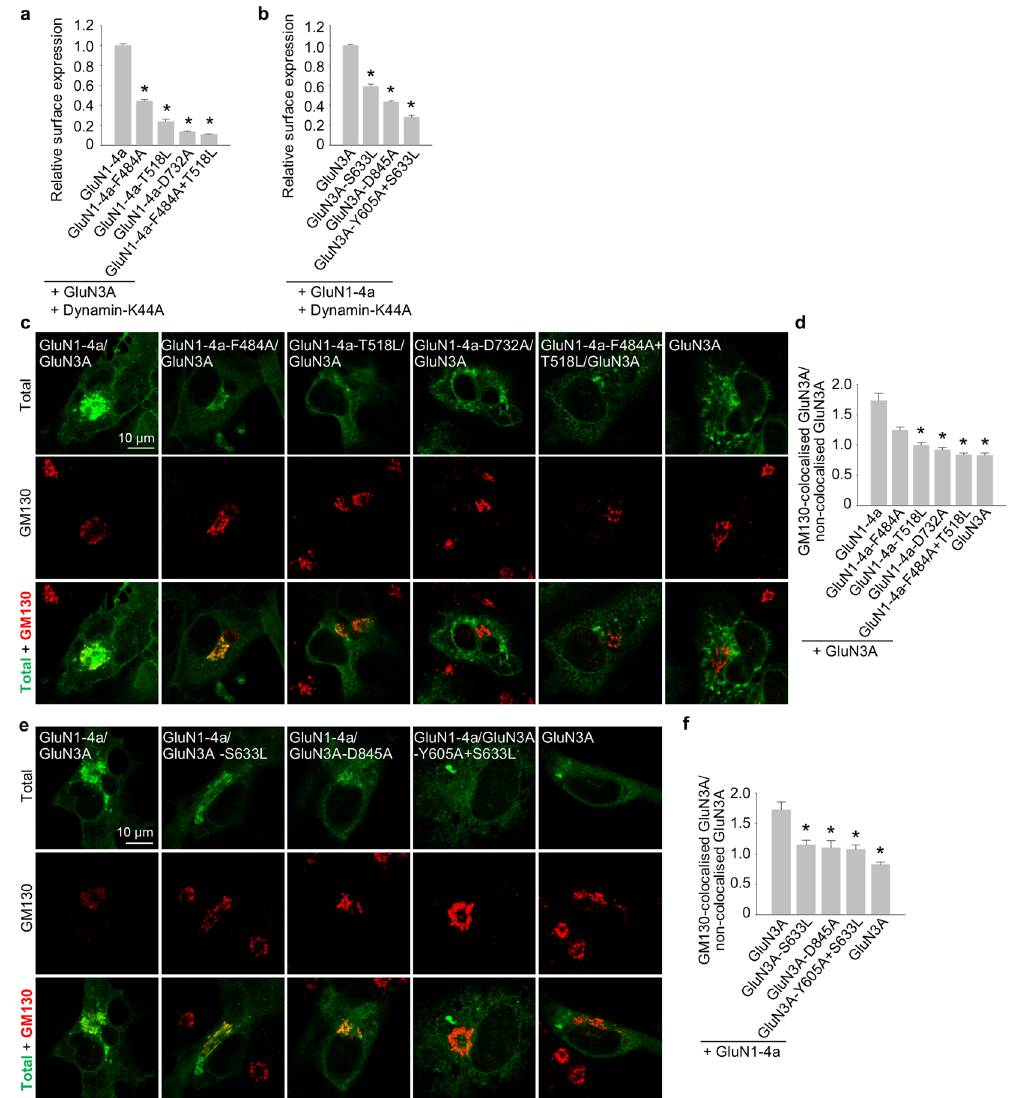
Figure 4. The glycine-binding sites in the GluN1 and GluN3A subunits regulate forward trafficking of GluN1/ GluN3A receptors ( a,b ) HEK293 cells co-expressing the indicated GluN1-4a and GFP-GluN3A (GluN3A) subunits together with the dynamin-K44A were labelled with primary anti-GFP and secondary antibodies in non-permeabilizing and permeabilizing conditions. The bar graphs show quantification of relative surface expression of the indicated GluN subunit combinations obtained using quantitative colorimetric assay (n = 6); * p < 0.05 relative to GluN1-4a/GluN3A (ANOVA). ( c,e ) Representative confocal microscopy images of the COS-7 cells transfected with the indicated GluN1-4a and GFP-GluN3A (GluN3A) subunits; the anti-GM130 antibody was used to label the GA. (d,f) Summary of the average intensity of GFP-GluN3A (GluN3A) subunit signal colocalised with GM130 over the average intensity of GFP-GluN3A (GluN3A) subunit signal outside GM130 signal, calculated for the indicated GluN subunit combinations (n ≥ 10 cells); * p < 0.05 vs. GluN1-4a/ GluN3A;